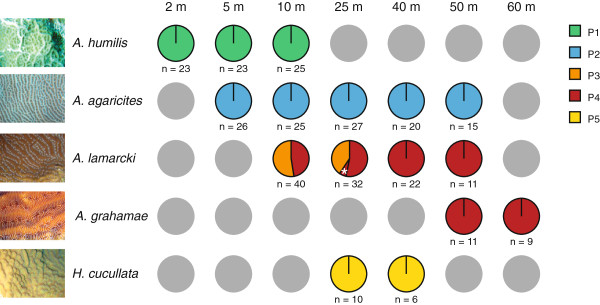
Distribution of Symbiodinium ITS2 profiles across the five agariciid host species and depths. Each pie chart represents the sampled population of a host species at a certain depth. Asterisk (*) indicates a P4 profile that had an additional C1 band. Figure legend text.